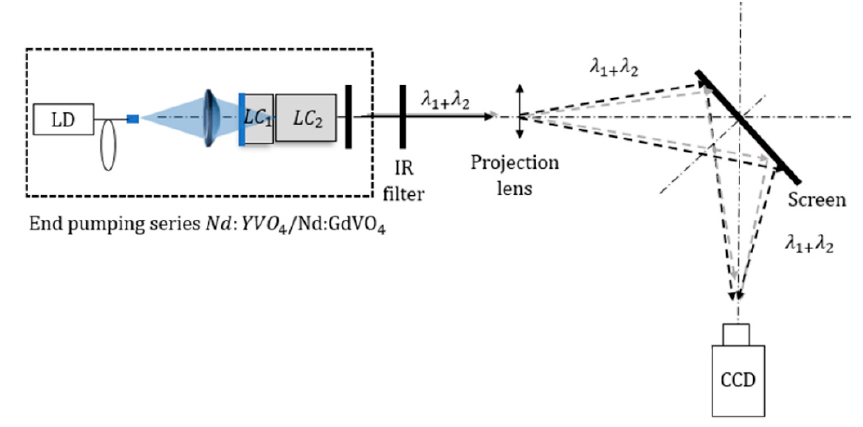
Figure 3. Experimental setup for speckle test.